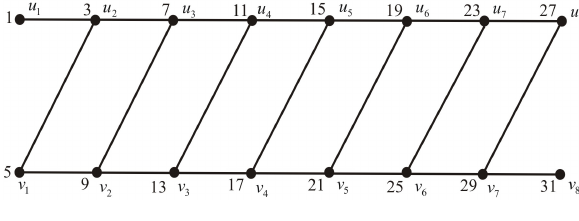
Figure 1: Z − ( P n ) and its odd prime